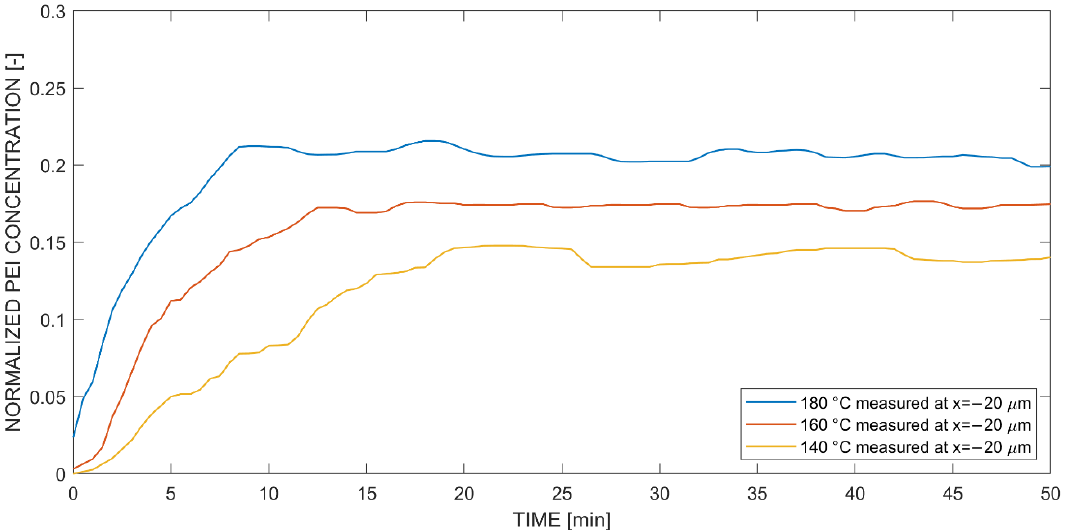
Figure 11. Temperature-dependent concentration curves normalized to Raman intensity amplitude 2437@1003 cm −1 at coordinate x = −20 μm (negative) for diffusion of the PEI into (reactive tude 2437@1003 cm − 1 at coordinate x = − 20 µ m (negative) for diffusion of the PEI into (reactive multicomponent) epoxy system. multicomponent) epoxy